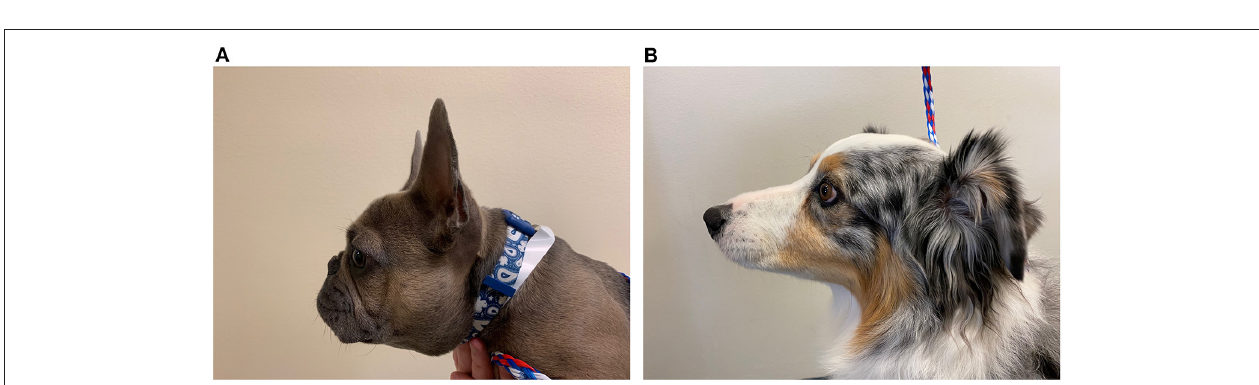
FIGURE 6 | Brachycephalic vs. dolicocephalic conformation. (A) Picture of a brachycephalic 9-month-old French Bulldog showing the foreshortened muzzle, round face, and nasal folds in comparison to (B) . (B) Picture of a dolicocephalic breed dog, 7-year-old Australian Shepherd, with an elongated muzzle.